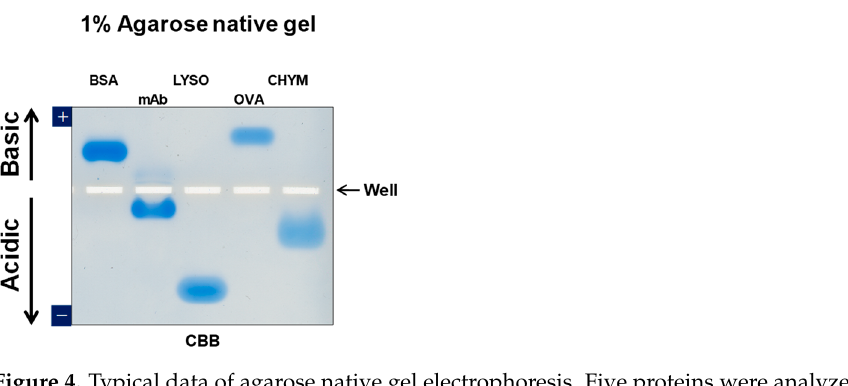
Figure 4. Typical data of agarose native gel electrophoresis. Five proteins were analyzed by agarose native gel electrophoresis. 1% UltraPure agarose was used and stained by CBB. Arrows show direction of acidic or basic proteins to migrate. Samples were loaded in the center position (marked Well).